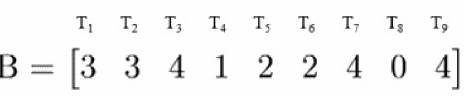
Figure 18. Baseline Redundancy Matrix (B) for the example.